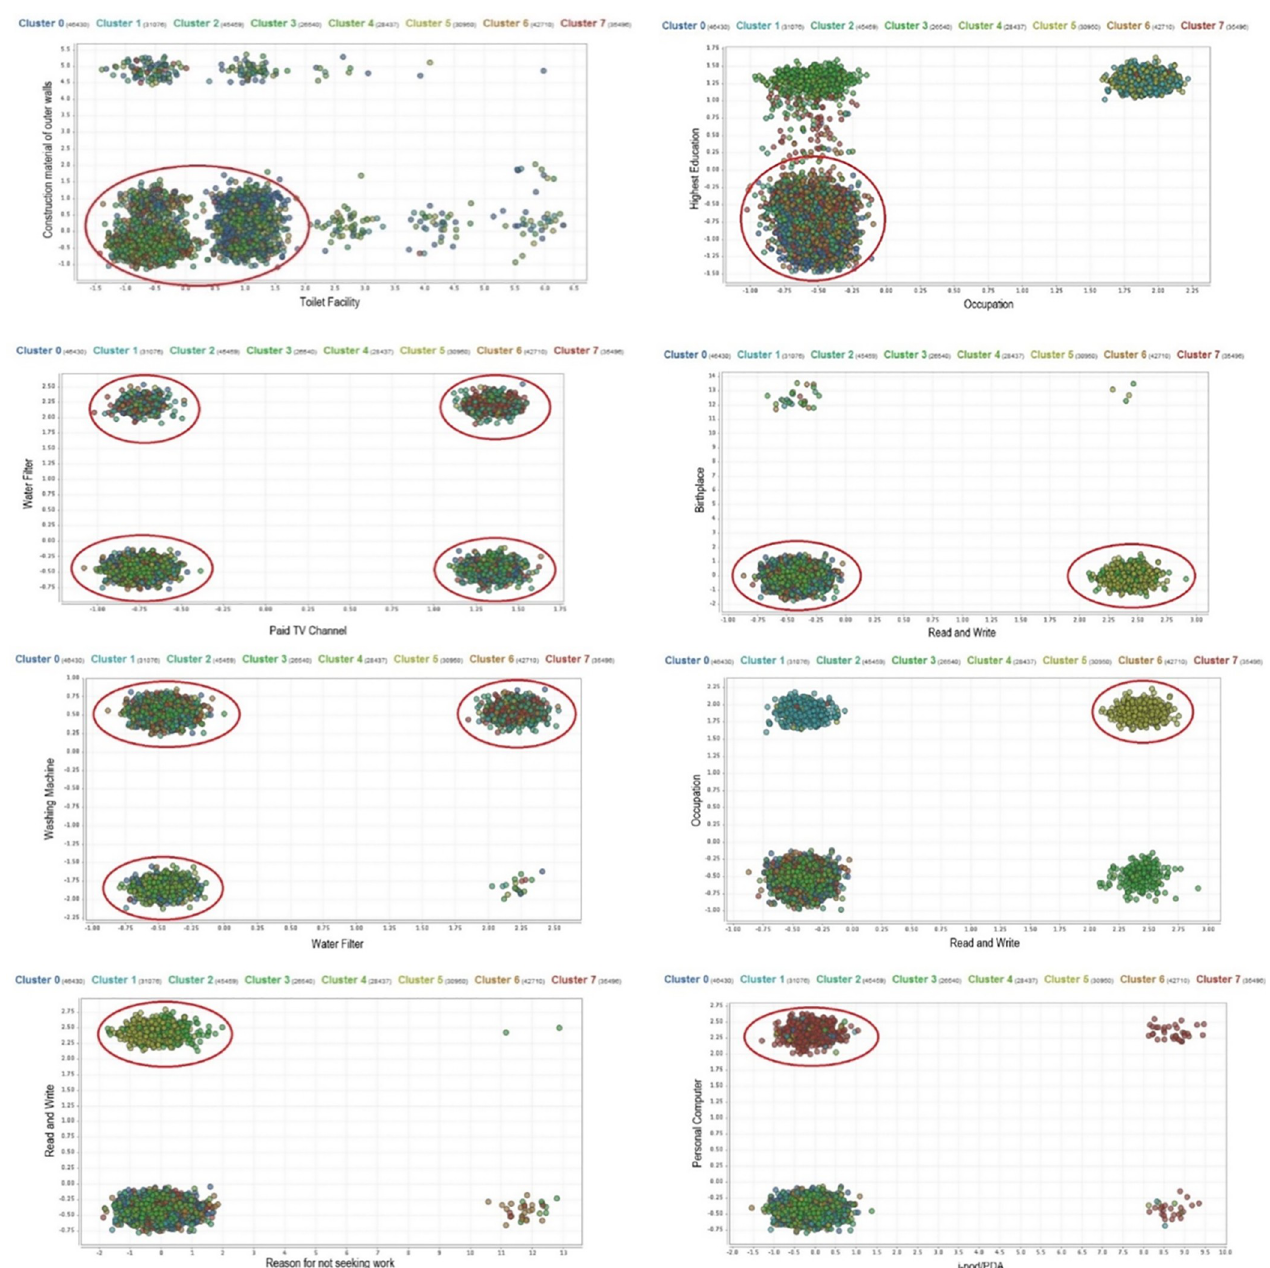
Fig 4. Scatter plot of (a) Cluster 0; (b) Cluster 1; (c) Cluster 2; (d) Cluster 3; (e) Cluster 4; (f) Cluster 5; (g) Cluster 6; (h) Cluster